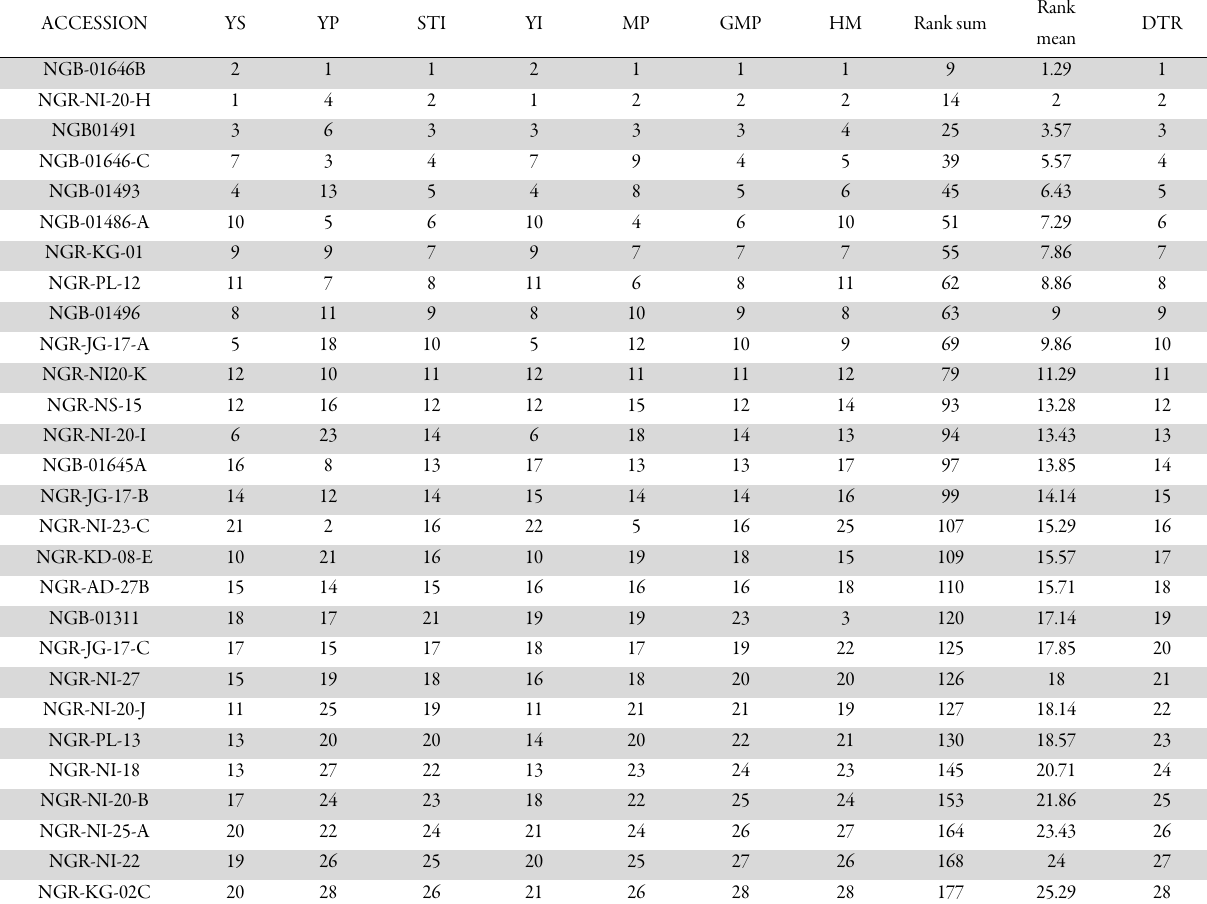
Table 4. Rank, rank sum, rank mean of some drought tolerance indices and drought tolerant ranking